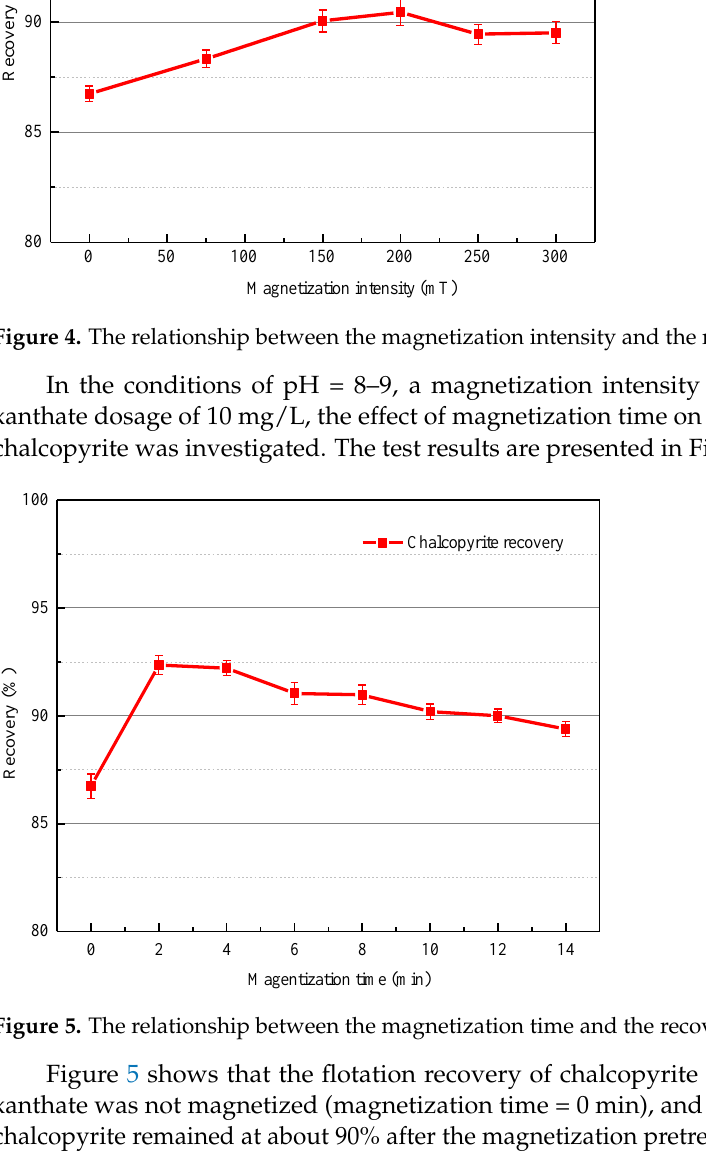
Figure 4. The relationship between the magnetization intensity and the recovery of chalcopyrite.